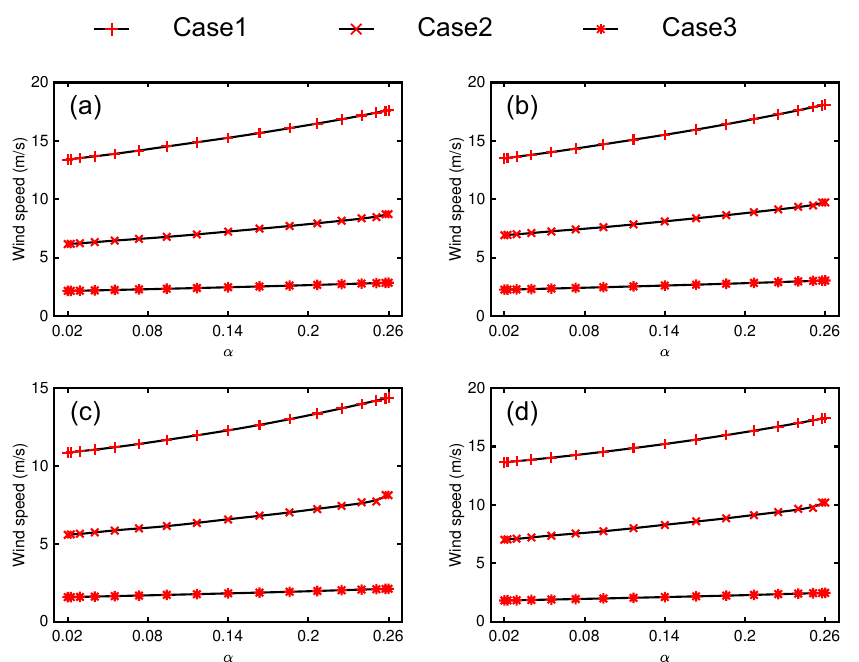
Figure 6. The quadrature points and reconstructed profiles on the stochastic domain for turbine No.1 ( a ), No.3 ( b ), No.9 ( c ), and No.15 ( d ). The black lines are the reconstructed profiles via the stochastic collocation method using the values at the quadrature points.